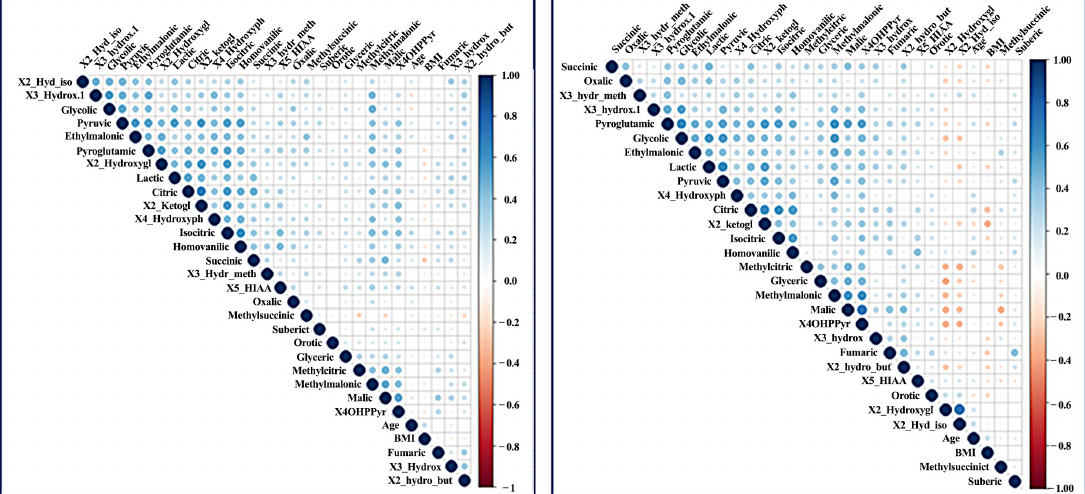
Figure 3. A scatter plot correlation matrix of the main variables used in the model. (Left) AD group (Right) Control group. Positive correlations are shown in blue and negative correlations are shown in